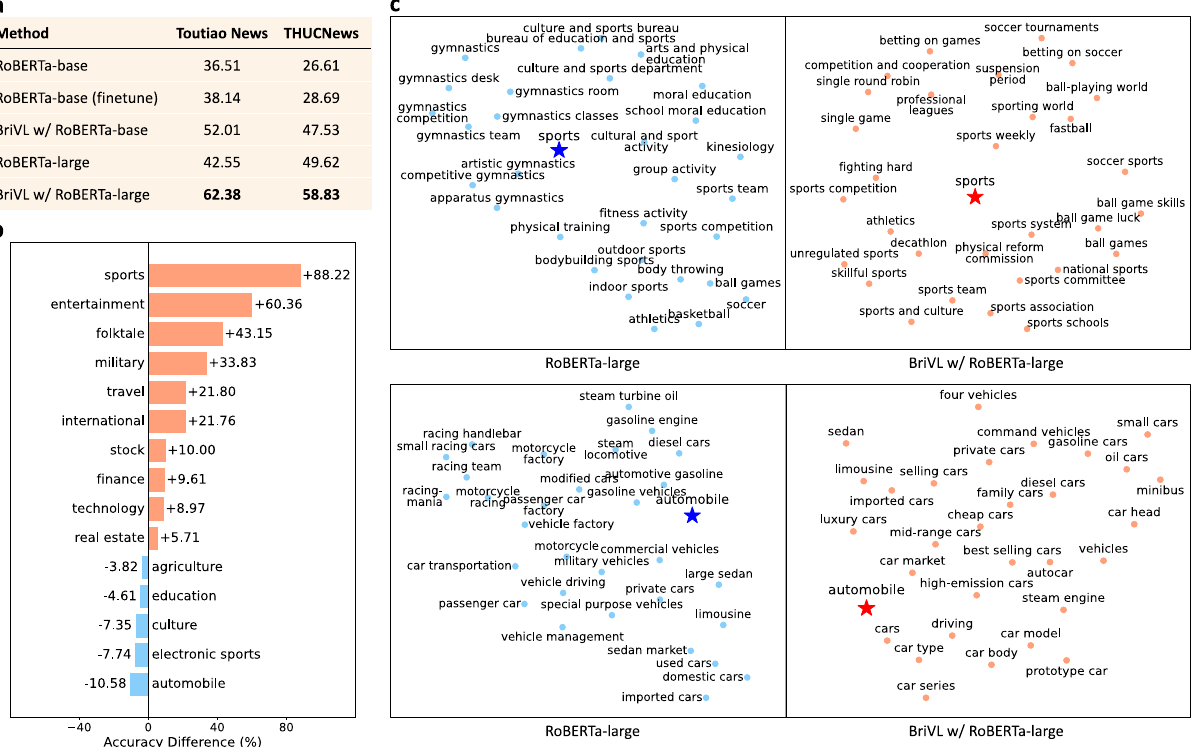
Fig. 5 Zero-shot news classi fi cation results. a Zero-shot news classi fi cation results (%) on two Chinese news datasets. b Zero-shot accuracy gain/loss (%) of BriVL w/ RoBERTa-large comparing to RoBERTa-large on each category of Toutiao News. c Top-30 phrase retrieval results of “ sports ” (top) and “ automobile ” (bottom) using RoBERTa-large and BriVL w/ RoBERTa-large, respectively. The candidate phrase list is obtained from Jieba, which consists of 347,728 Chinese phrases. We translate the results into English for presentation clarity. Highest results in ( a ) are highlighted in